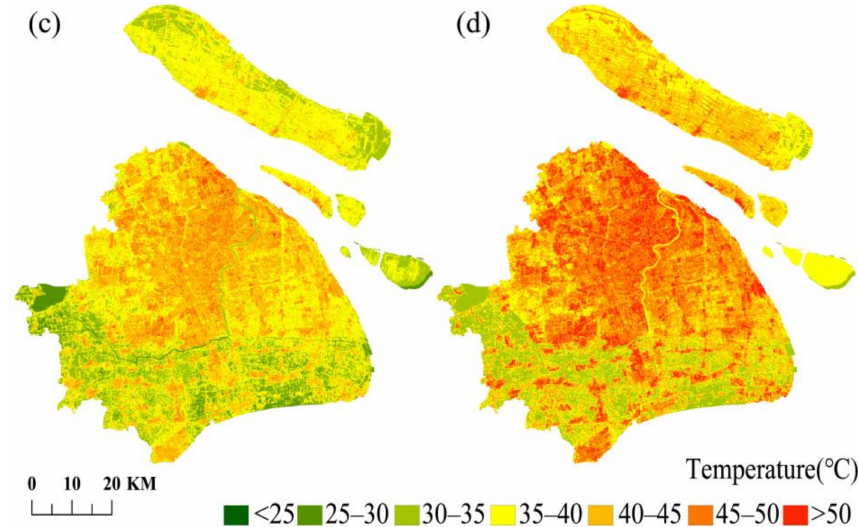
Figure 3. Comparison of the retrieval results of four algorithms on 16 August 2020. ( a – d ) are RTE, MWA, SWA, and SCA retrieval results, respectively.